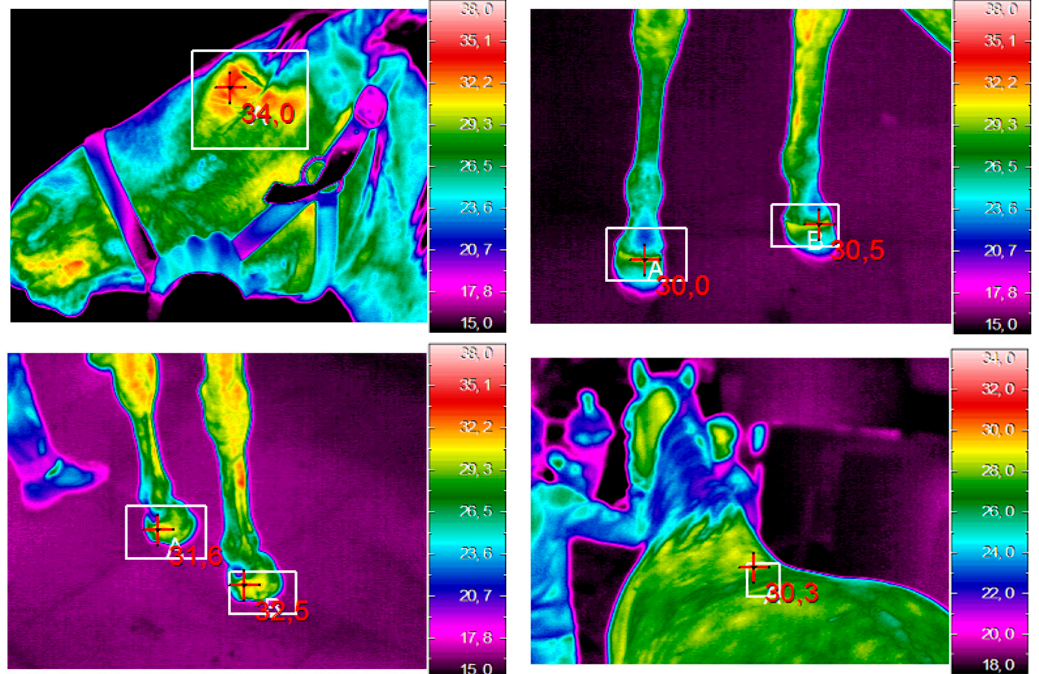
Figure 5. Examples of an infrared image in the examined regions. The cross indicates the position of the maximum temperature within the examined areas used for analysis.